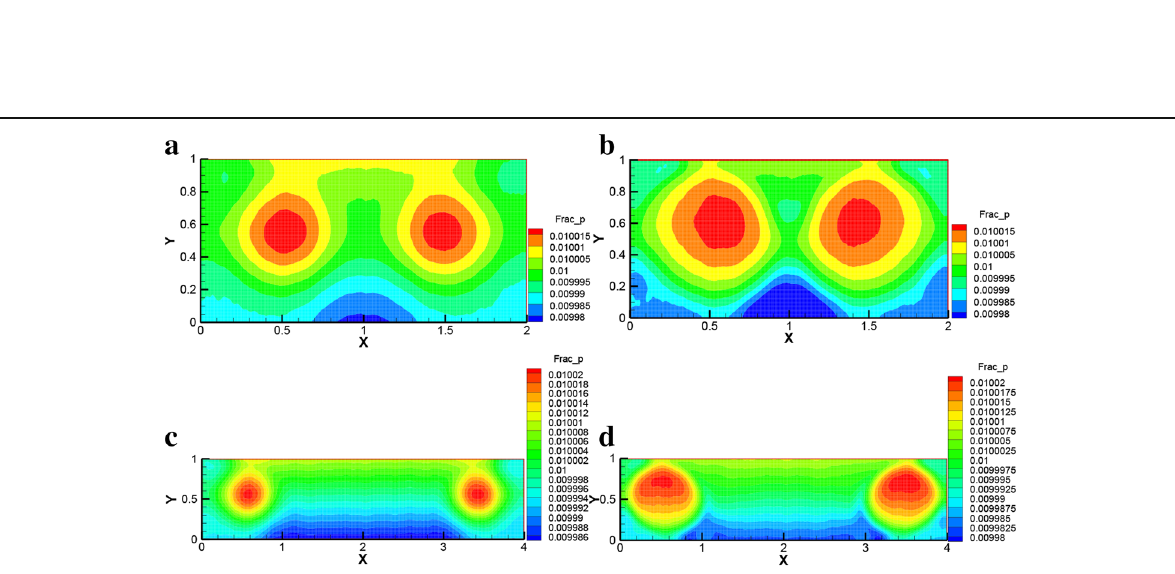
Fig. 3 Nanoparticle volume fraction distributions of Ag-Ga nanofluid. Nanoparticle volume fraction distributions of Ag-Ga nanofluid ( r =20 nm, φ =0.01) in the horizontal rectangular enclosure ( A =2:1 and A =4:1). a Ra =1×10 3 , A =2:1. b Ra =1×10 5 , A =2:1. c Ra =1×10 3 , A =4:1. d Ra =1×10 5 , A